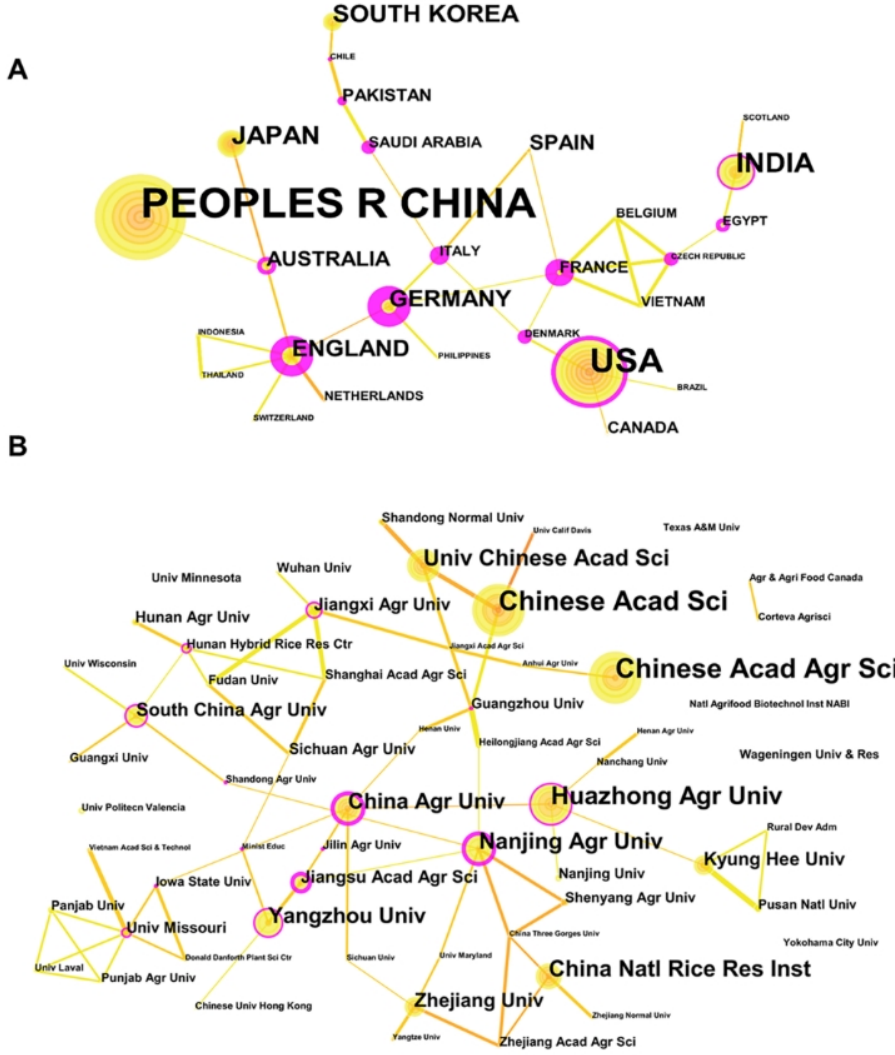
Figure 2. Country and institution cooperation and competition relationship map and journal distri- bution. ( A ) National cooperation network among 27 countries, reflecting the volume of publications by the size of the yellow circle and the intensity of cooperation by the thickness of the lines between the nodes; ( B ) cooperation network of 58